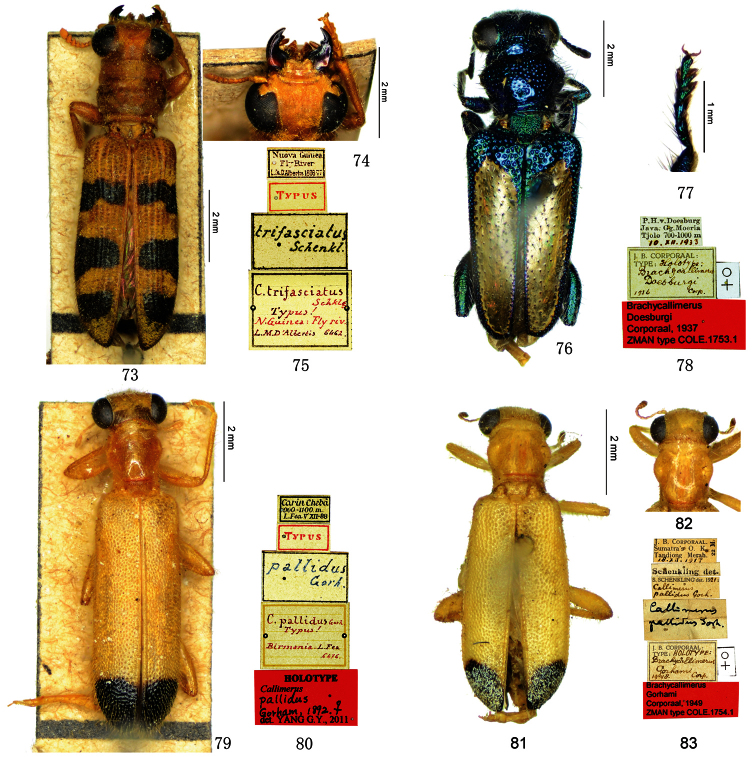
73–75 Lectotype ofCallimerus trifasciatus Schenkling, 1899 (73 habitus 74 head 75 labels) 76–78
Brachycallimerus doesburgi Corporaal, 1937 (76 habitus of holotype 77 hind leg of paratype 78 labels of holotype) 79–80 Holotype of Callimerus pallidus Gorham, 1892 (79 habitus 80 label) 81–83 Holotype of Callimerus gorhami Corporaal, 1949 (81 habitus 82 head 83 labels).